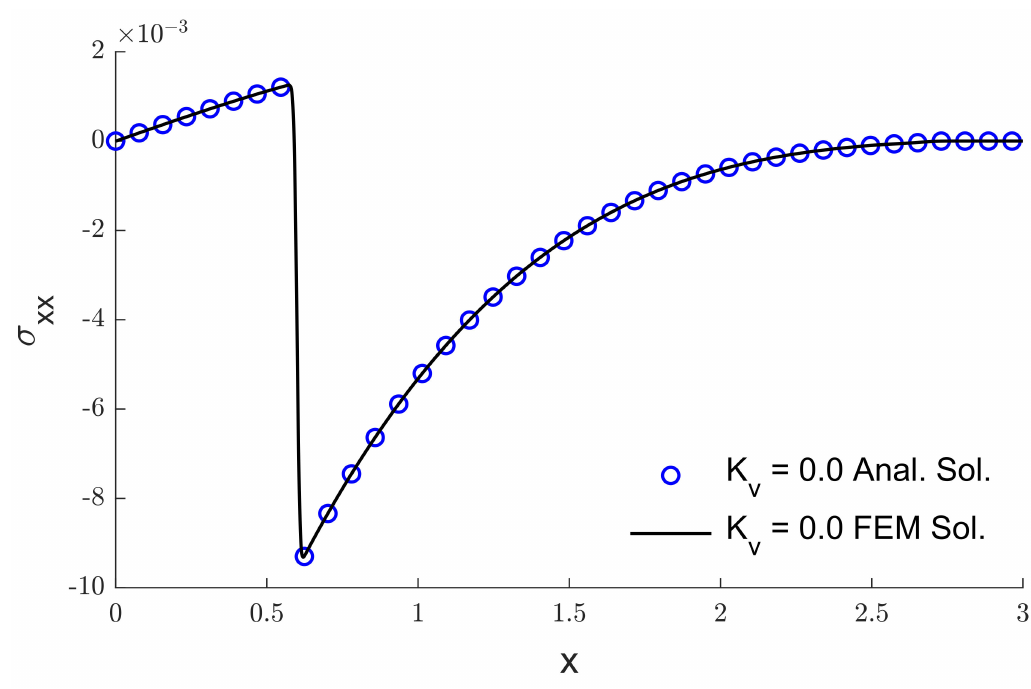
Figure 12. The stress variation with and without Kirchhoff transform when K v =